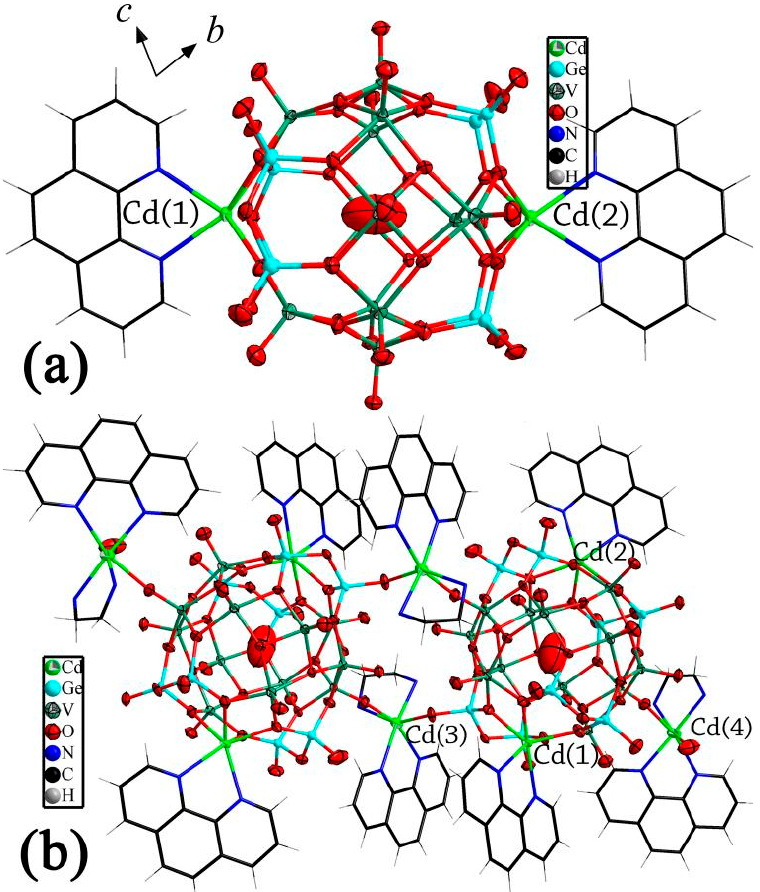
Figure 1. Ball-and-stick and wire representation of the di-Cd-substituted Ge-V-O cluster ( a ) and the dimer in compound 1 ( b